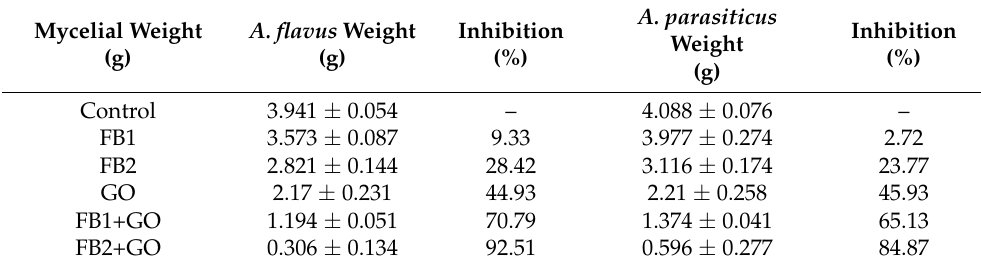
Table 4. The degradation of mycelial growth by film composites in simulated liquid